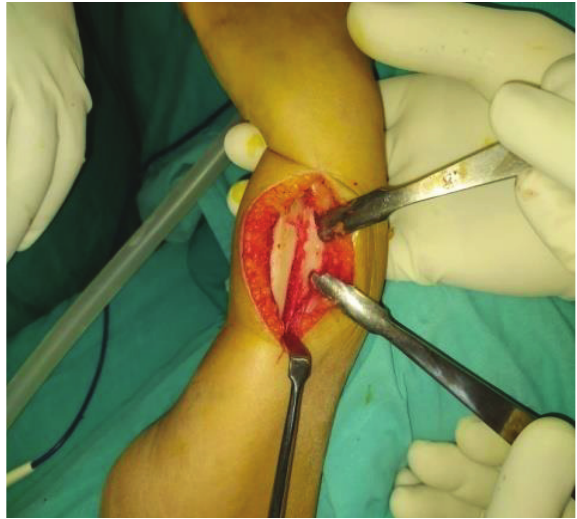
Fig-D: Per op pic showing distal ulnar exostosis